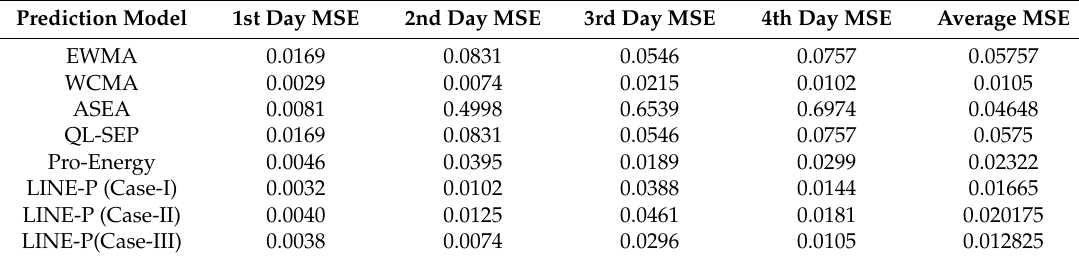
Table 1. MSE of the LINE-P (all cases) and other prediction models for solar energy.